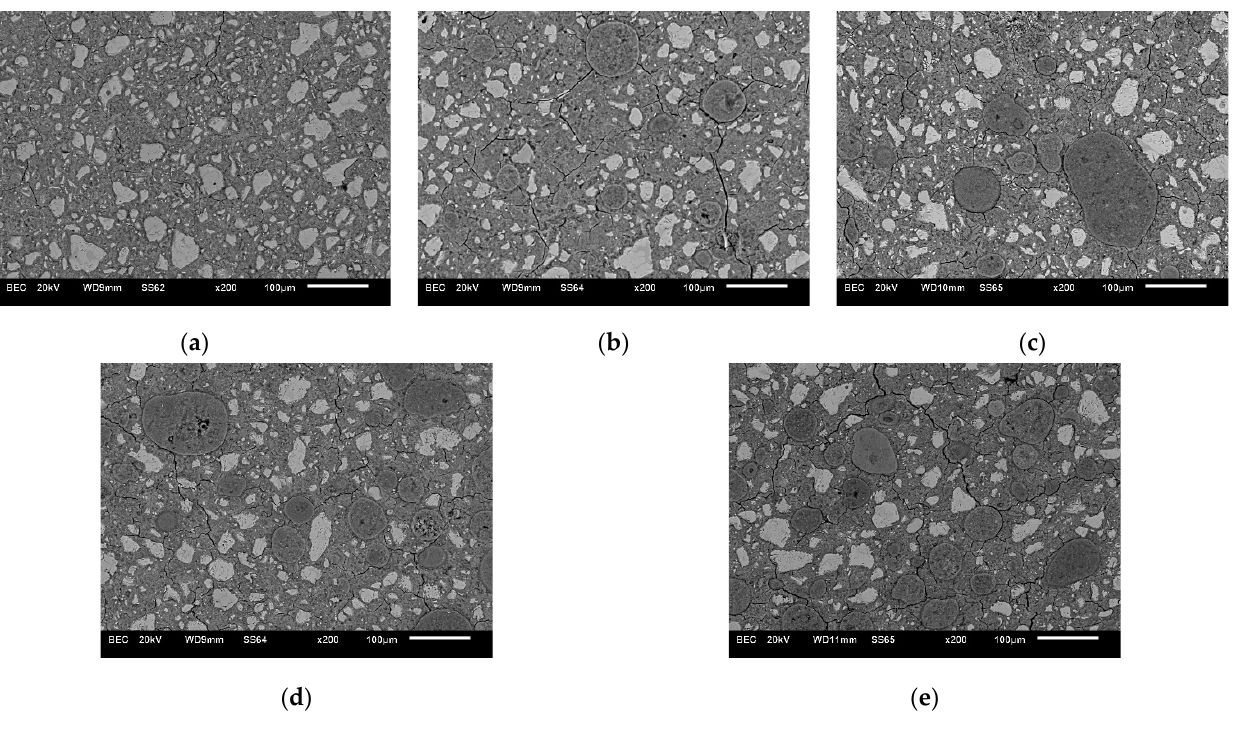
Figure 6. SEM images of microstructure of the respective cement paste samples: ( a ) 0.30 ref; ( b ) 0.30 5%; ( c ) 0.30 10%; ( d ) 0.30 15%; ( e ) 0.30 20%.